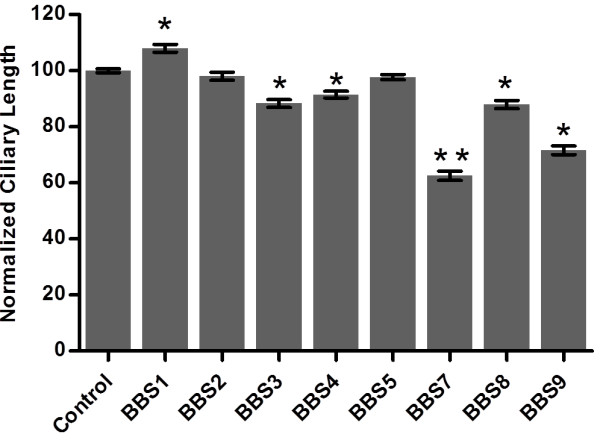
Normalized ciliary lengths of BBS-depleted cells. Data are averages of 138 to 798 cilia on 15 to 66 cells from three replicate experiments ± standard error of the mean (SEM). The control value before normalization was 11.72 μm ± 0.08 μm (average ± SEM, n = 798). Significant changes determined by the Mann–Whitney U-test are denoted as *P < 0.05, **P < 0.0001.